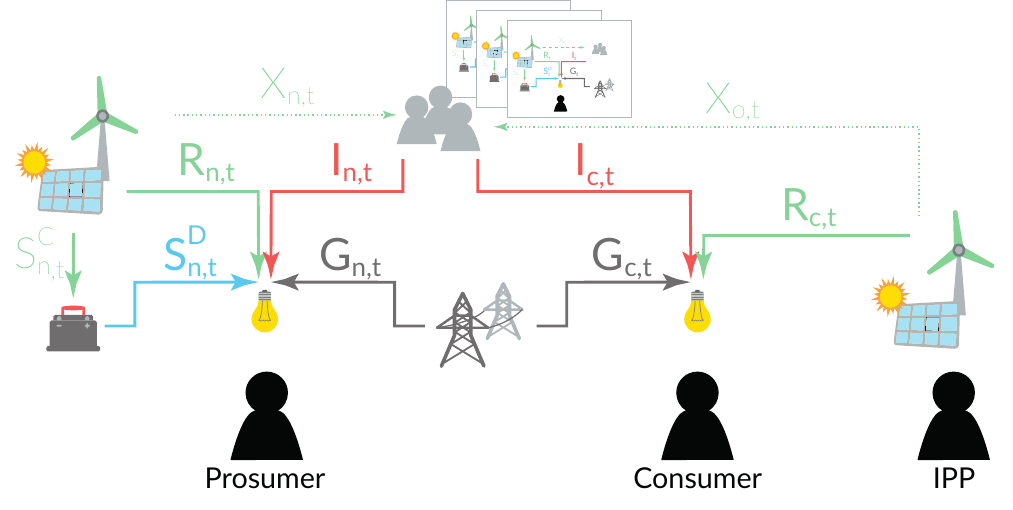
Figure 1. A stack of heterogeneous players.